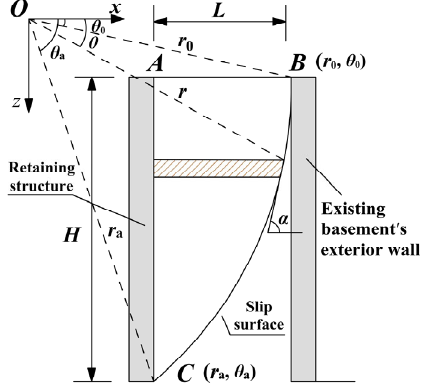
Figure 2. Sketch of logarithmic spiral slip surface.